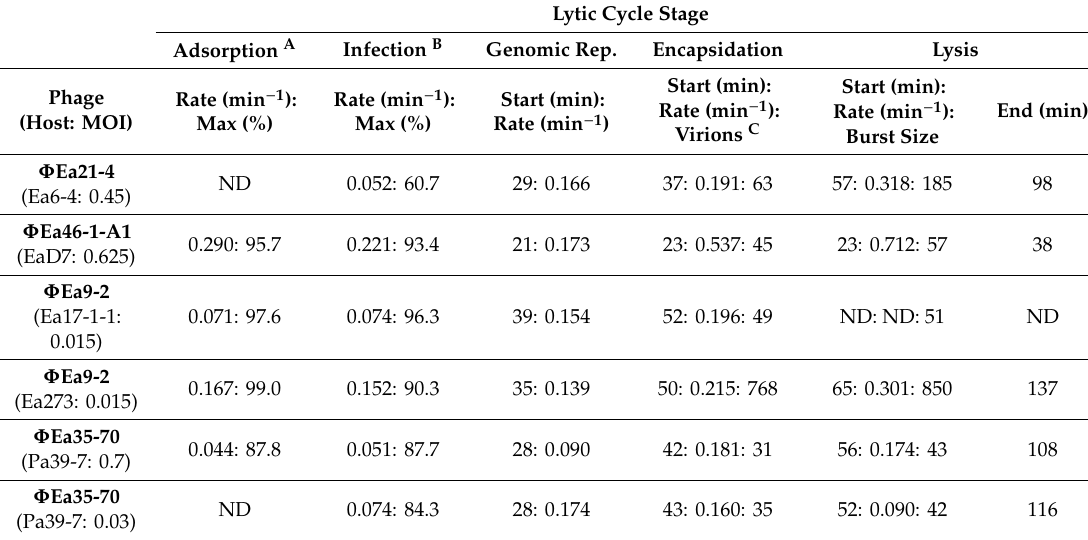
Table 1. Infection characteristics of the lytic cycle as determined through the molecular profile of phage